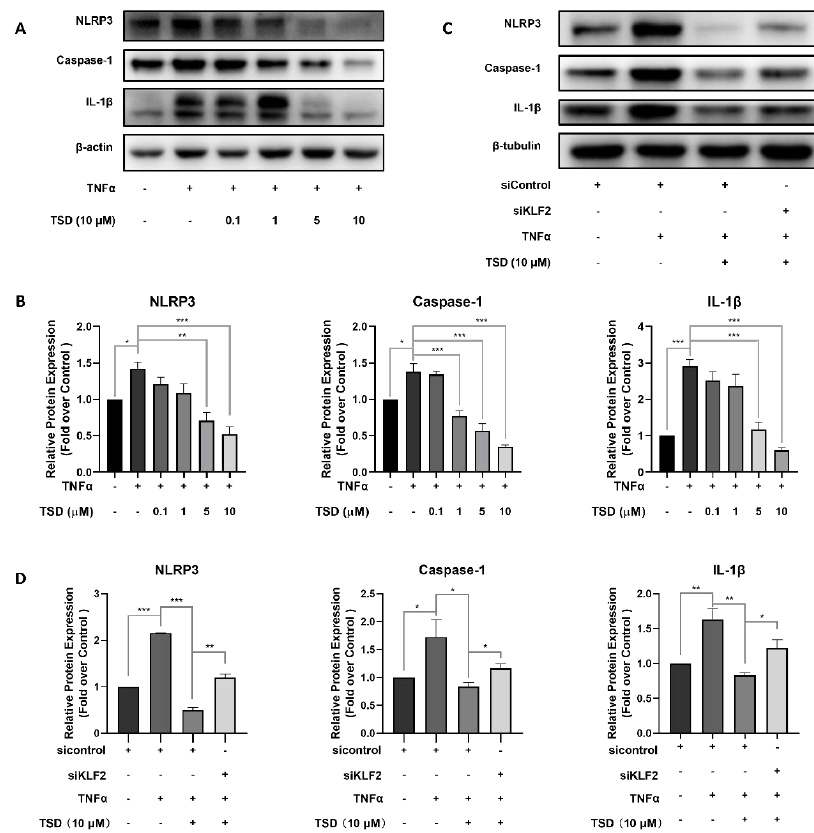
Figure 4. TSD exerts anti-inflammatory effects on HUVECs via inhibition of the NOD-like receptor protein 3 (NLRP3)/Caspase-1/interleukin-1beta (IL- 1β) signaling pathway. ( A , B ) Representative western blots ( A ) and quantification ( B ) of the protein expression of NLRP3, Casapase-1, and IL- 1β after treatment with TSD. Cells in 6-well plates were treated with or without TSD (0, 0.1, 1, 5, and 10 μM) for 18 h, and TNFα (10 ng/mL) was added for 6 h. Western blot was performed to assess NLRP3, Casapase-1, and IL- 1β protein levels. ( C , D ) Representative western blots ( C ) and quantification ( D ) of the protein expression of NLRP3, Casapase-1, and IL- 1β after treatment with siControl and siKLF2. HUVECs were cultured in 6-well plates and transfected with siControl or siKLF2 with Lipofectamine RNAi MAX for 6 h. Then, the medium was replaced with endothelial cell medium and incubated for another 18 h. Then, the cells were treated with or without TSD (10 μM) for 18 h, followed by 10 ng/mL of TNFα for 6 h. Western blot was performed to assess NLRP3, Casapase-1, and IL- 1β protein levels. Each group was represented by a representative image. Values are represented as the mean ± SEM; n = 3; one-way ANOVA was used for analysis. * p < 0.05, ** p < 0.001, *** p < 0.0001.